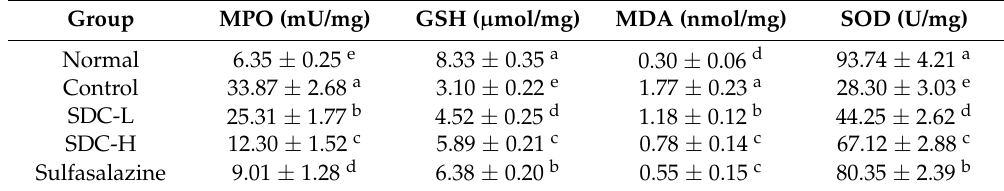
Table 13. Myeloperoxidase (MPO), superoxide dismutase (SOD), glutathione (GSH), and malondialdehyde (MDA) levels in colon tissues of mice. Group